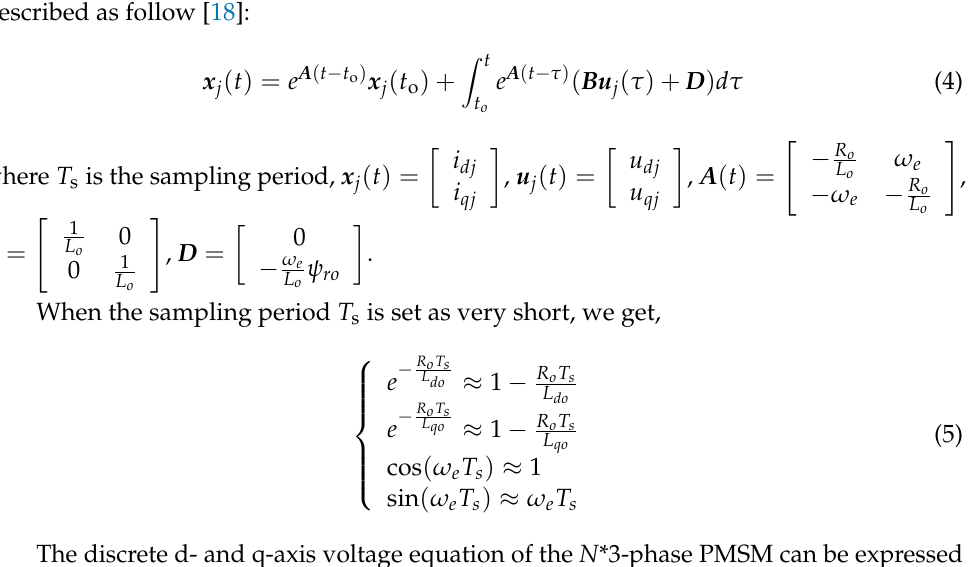
Figure 4. Robust predictive power control method of the N *3-phase PMSM drive system.